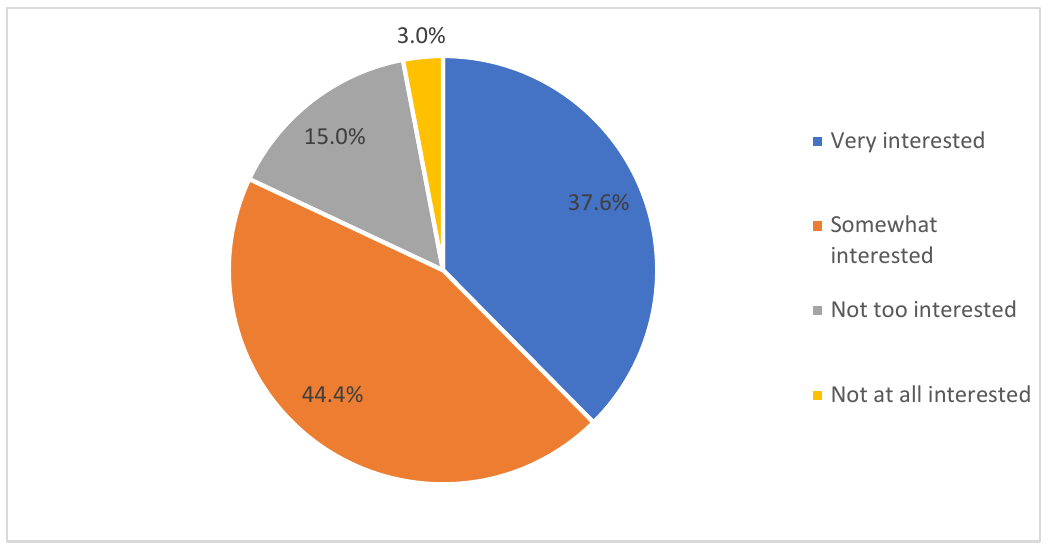
Figure 2. Participants’ levels of interest in using eHealth applications. Table 3. Participants’ levels of acceptance for using the following activities on eHealth